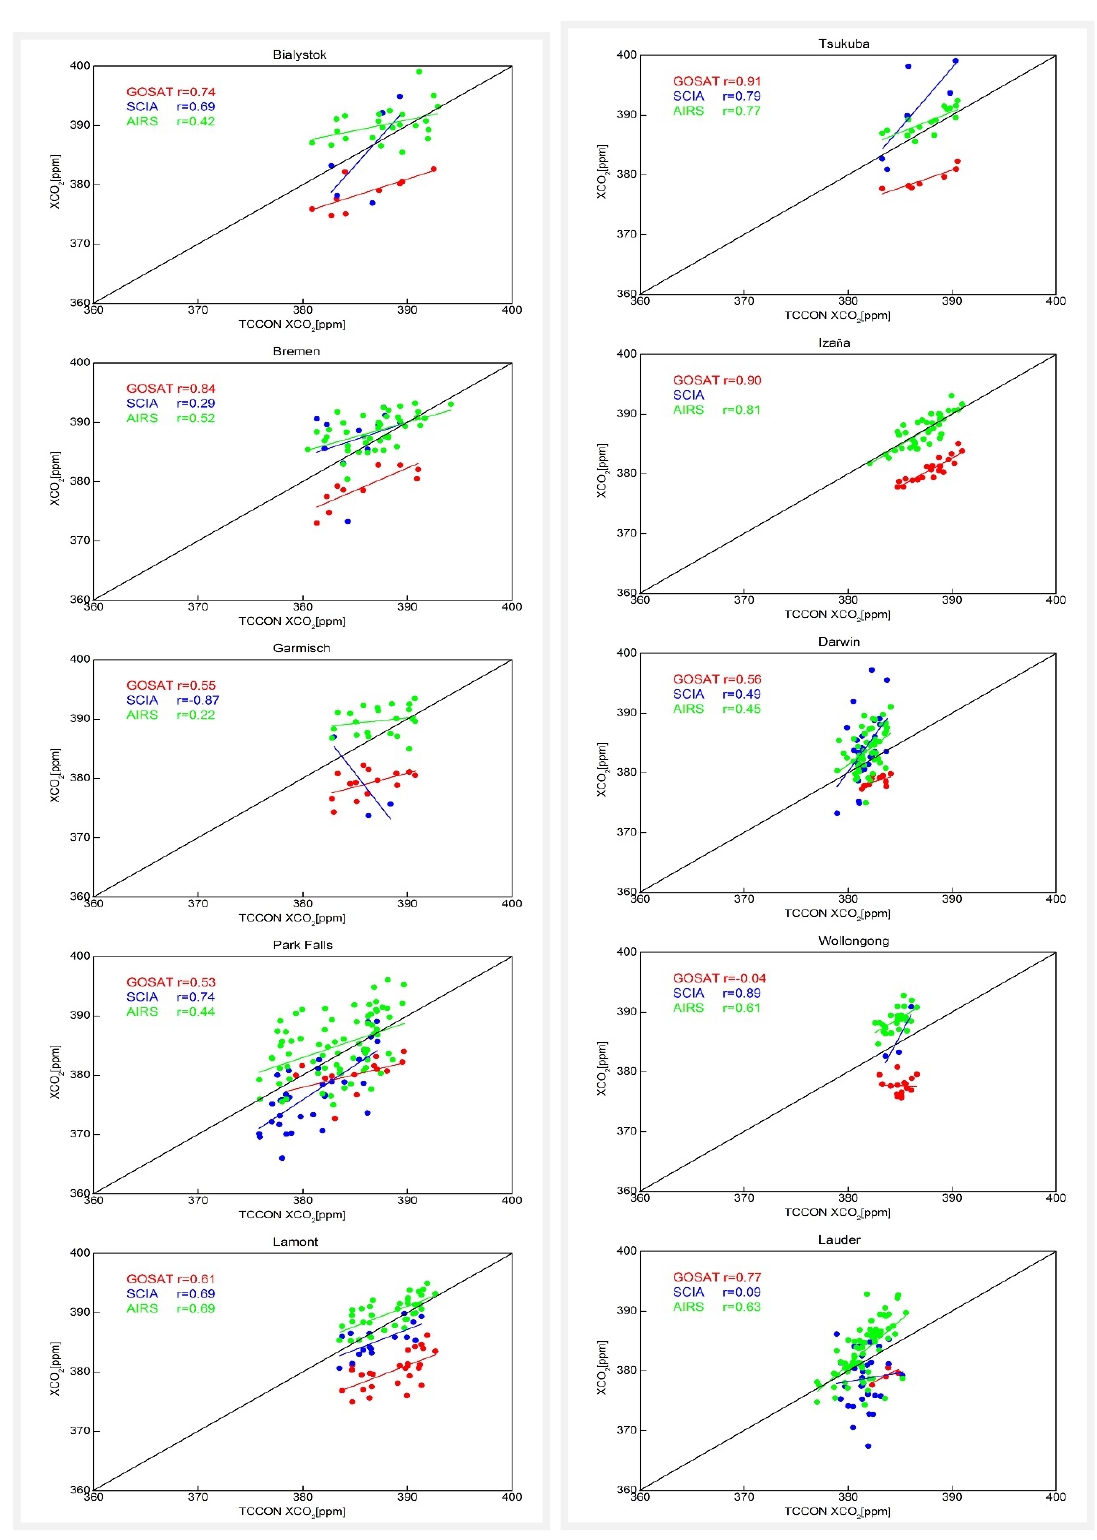
opposing trend from the g-b FTS data at Garmisch, mainly because of fewer available data. Due to using the monthly mean data, the mean correlation coefficients of the three satellite data are less than 0.5. Figure 5. Scatter diagrams of the time series of the satellite product, GOSAT (red), SCIAMACHY (blue) and AIRS (green) and g-b FTS data, for XCO sites and the correlation coefficient ( r ). The solid lines are the trend for each satellite